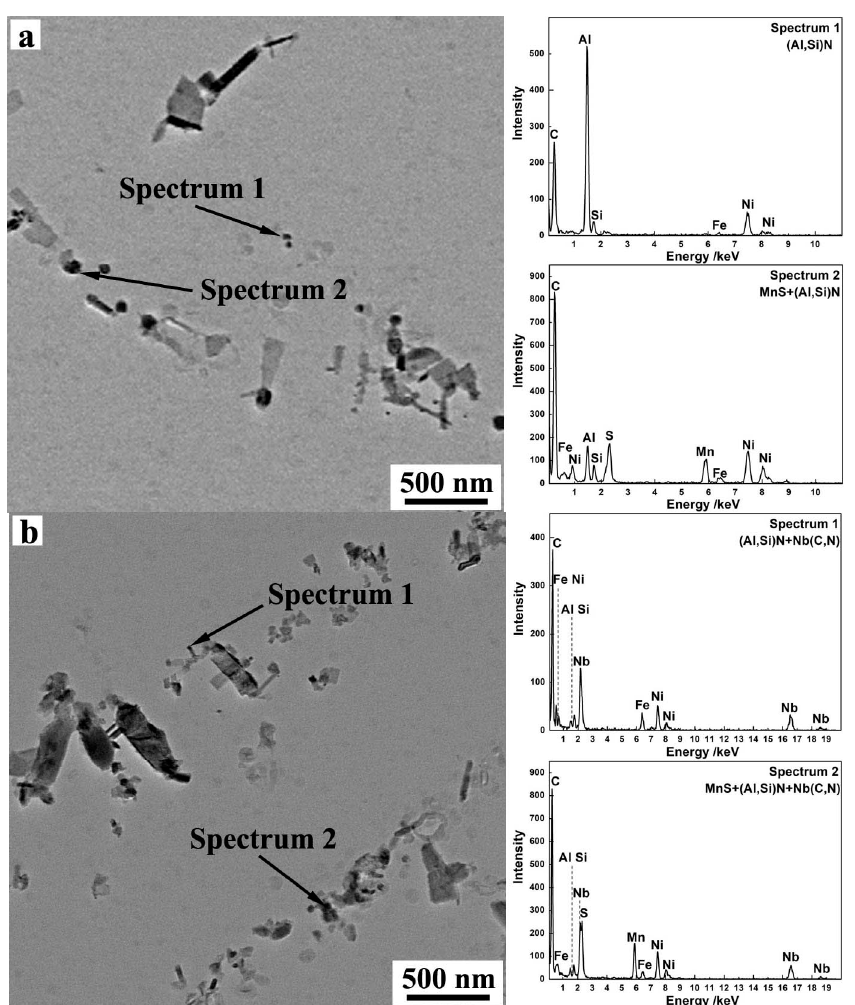
Figure 2. Typical shape and EDS analysis of precipitates in nitrided sheet: ( a ) precipitates in S1, ( b ) precipitates in S3.